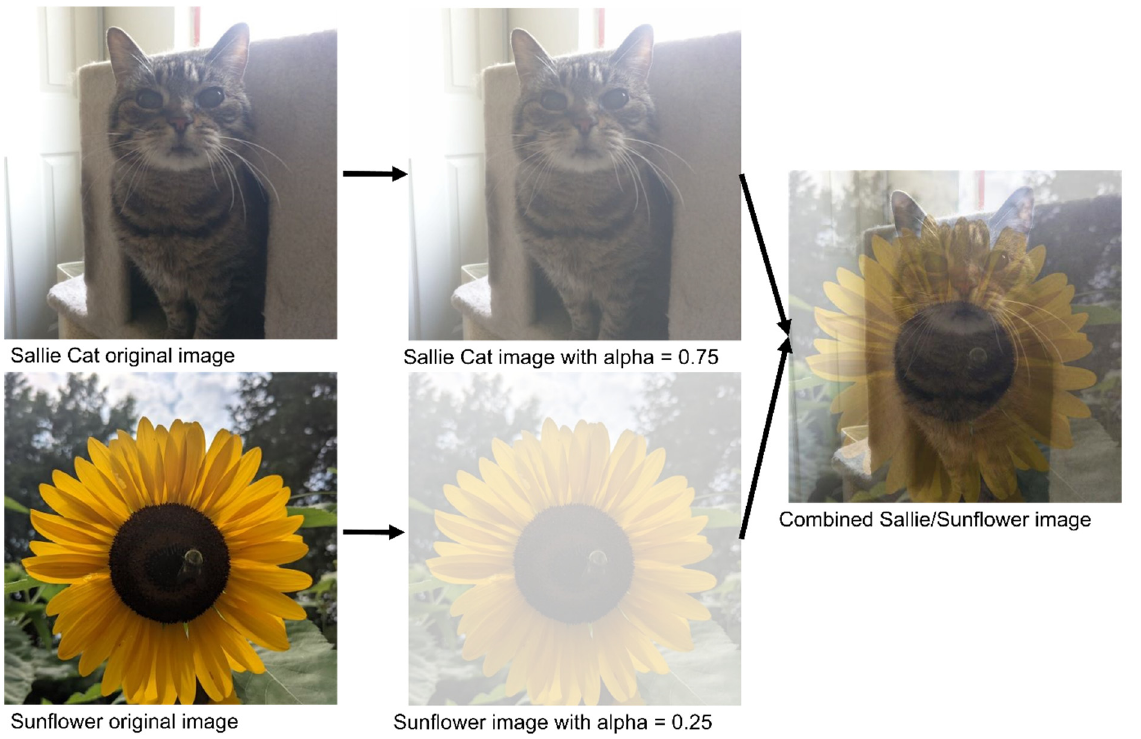
Figure 1. Visualization of the steps of MixUp data augmentation. Given two images to be mixed, the first image (top) is assigned a percentage representation value (between 0 and 1), and the second image is then assigned the complementary percentage representation. The two images are then combined to form the final image.